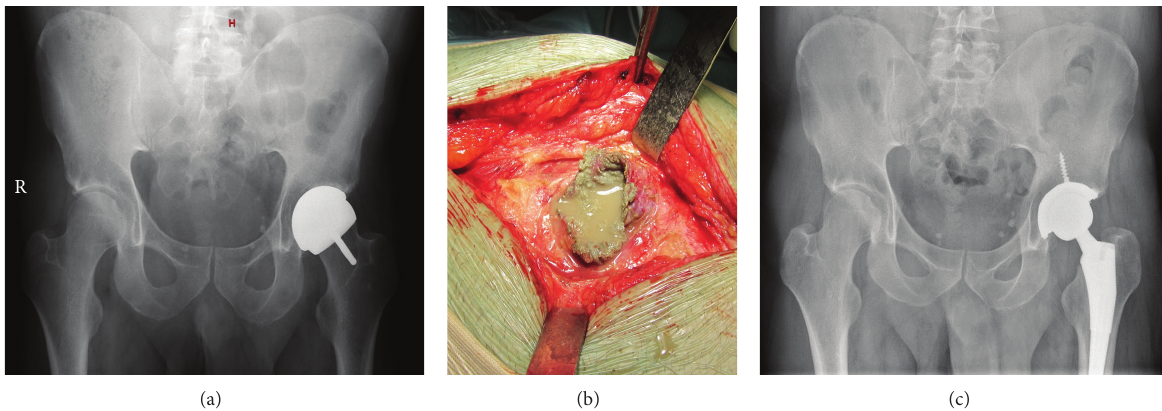
Figure 1: (a) Anterior-posterior radiograph of the pelvis prior to revision surgery, showing no relevant radiological findings related to the implant; (b) intraoperative appearance of the pseudotumour during revision surgery; and (c) radiograph of the same patient 6 months after